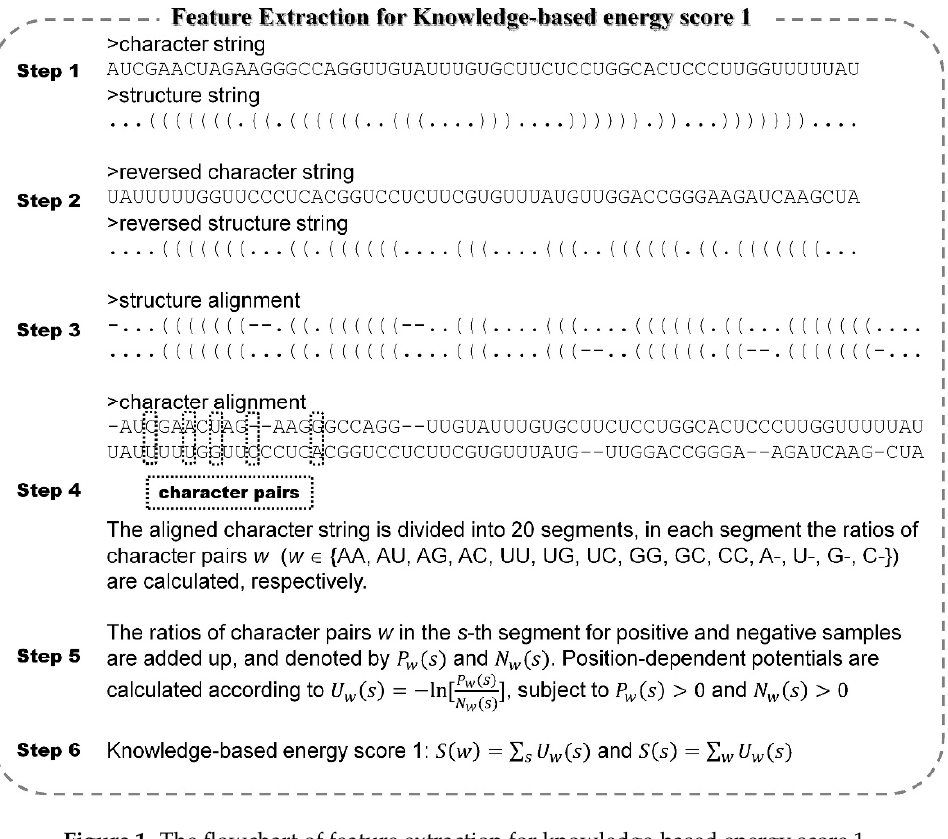
Figure 1. The flowchart of feature extraction for knowledge-based energy score